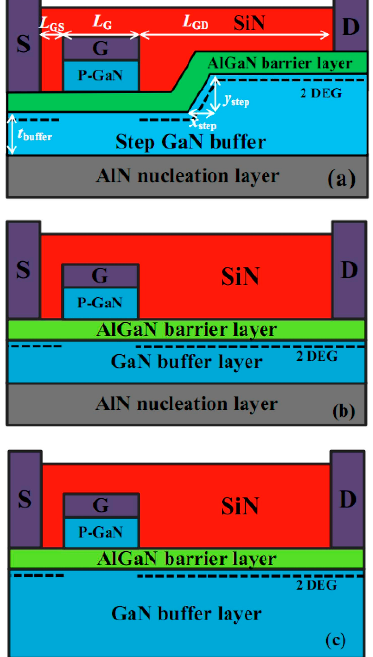
Figure 17. Proposed schematics of ( a ) SGB, ( b ) TGB, and ( c ) CGB. Reprinted with permission from ref. [219]. Copyright 2021 Elsevier.